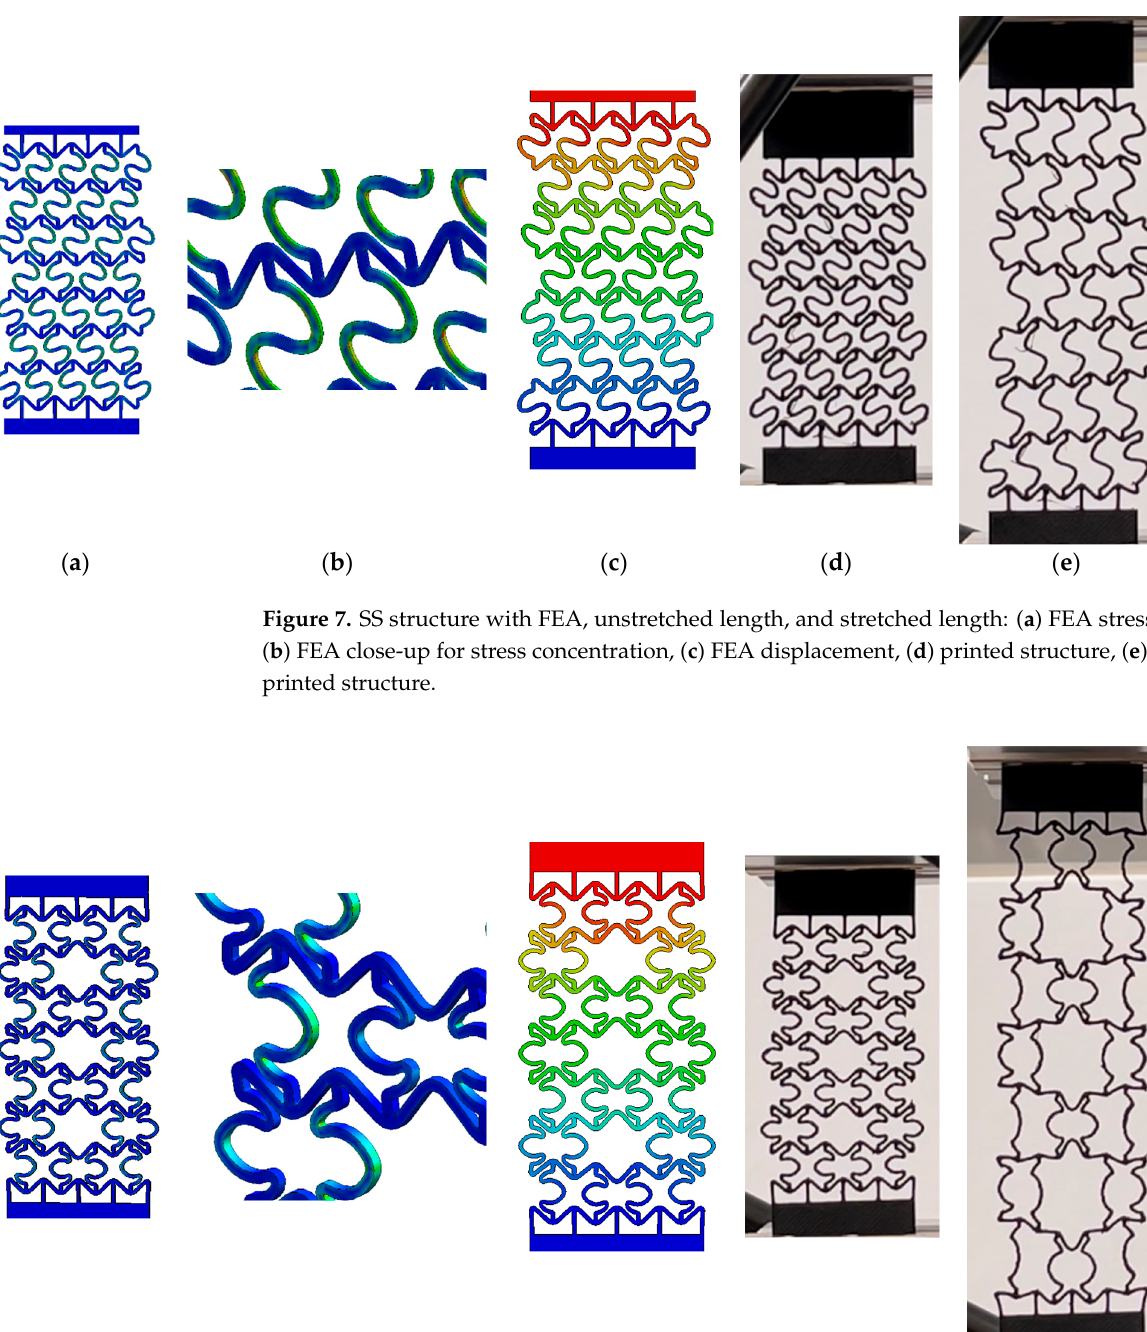
Figure 8. HISS structure with FEA, unstretched length, and stretched length: ( a ) FEA stress analysis, ( b ) FEA close-up for stress concentration, ( c ) FEA displacement, ( d ) printed structure, ( e ) stretched printed structure.